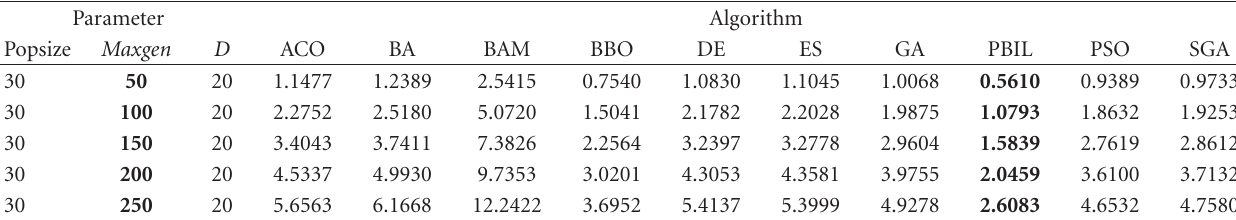
Table 5: Average CPU time on UCAV path planning problem on di ff erent Maxgen . The numbers shown are the minimum average CPU time (sec) consumed by each